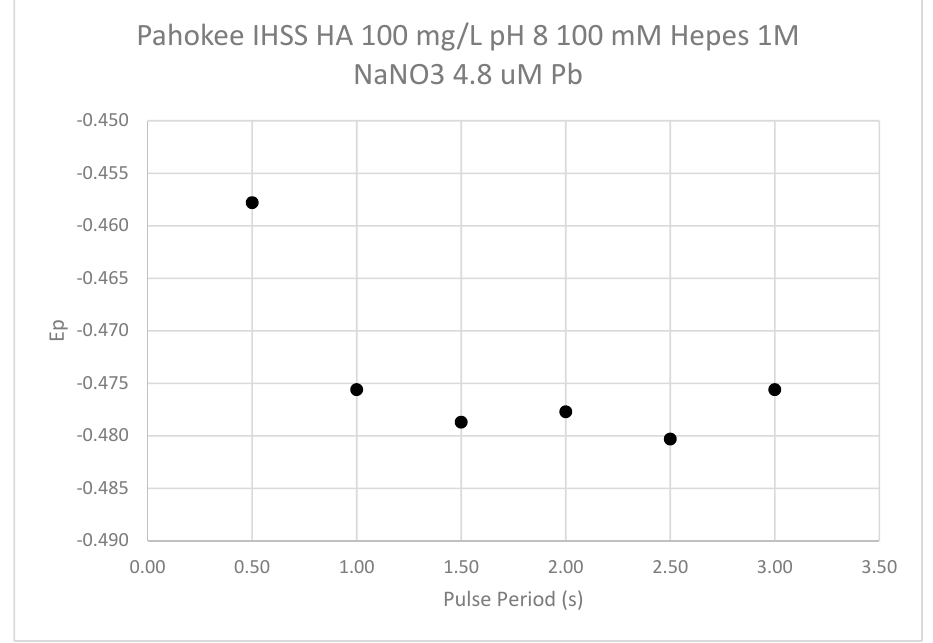
Figure 16. The influence of the DPP pulse period on the Ep value. The results are shown for Pahokee peat humic acid at 100 mg/L and a pH of 8 and in the presence of 1.0-M NaNO 3 . The Pb 2+ concentration was 4.8 uM.